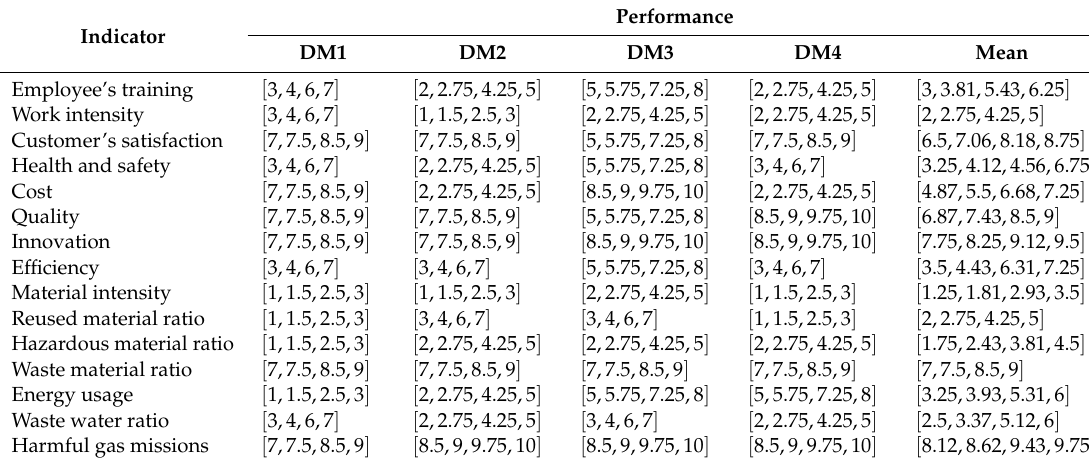
Table 6. The fuzzy judgements and the mean of performance.